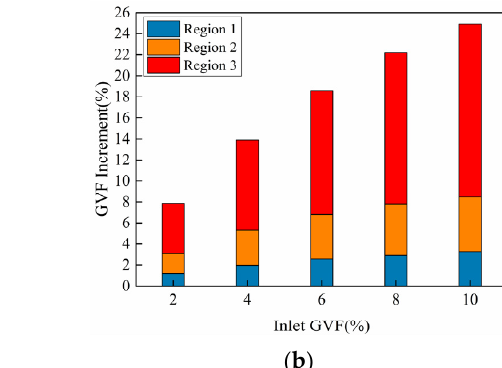
( b ) Figure 6. Mixture density along the axial direction under different conditions. ( a ) Under different inlet GVFs with a con- stant Δ P of 31 bars, ( b ) under different pressure differences with a constant inlet GVF of 10%. Figure 7a illustrates the mixture viscosity changes along the axial direction with in- creasing inlet gas content when Δ P = 31 bars. According to Equation (10), the viscosity of the liquid phase is two orders of magnitude greater than the viscosity of the gas phase, so the viscosity of the liquid phase dominates. Therefore, the mixture viscosity decreases as the GVF increases. When the inlet GVF is constant, the decreasing rate of the mixture viscosity along the axial direction gradually increases. At the same dimensionless axial seal position, the increase of inlet GVF results in the mixture viscosity decreasing faster.